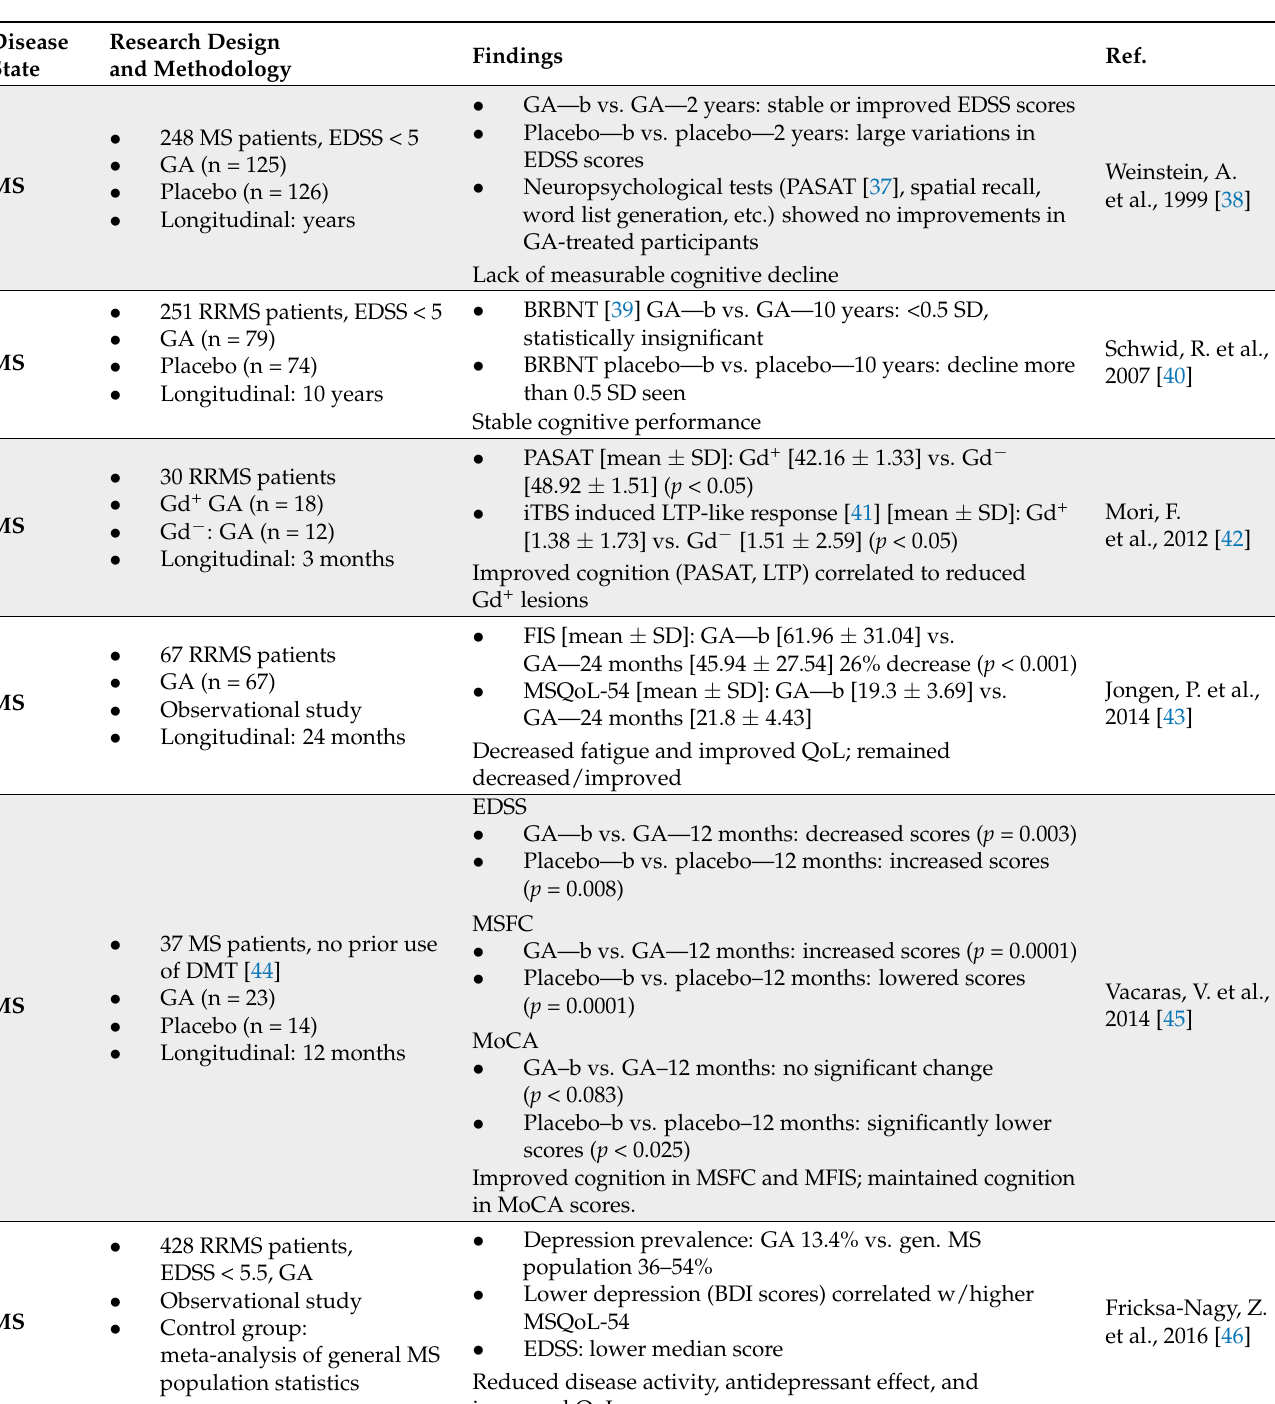
Table 1. Clinical Trials Examining Cognitive Outcomes of Glatiramer Acetate Immunization in Multiple Sclerosis